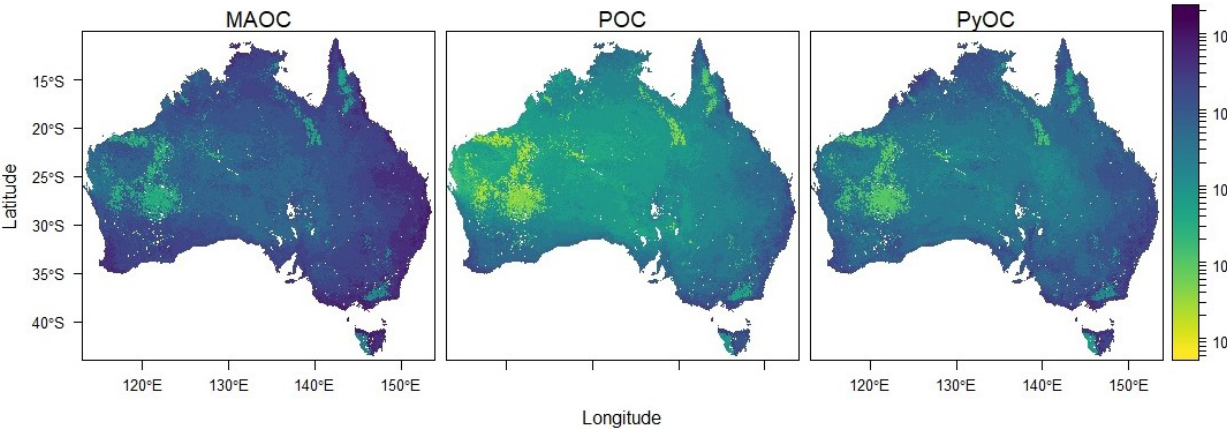
Figure 8. SOC fraction stocks (0–30cm) (MgCha − 1 ). The values are represented in the log10